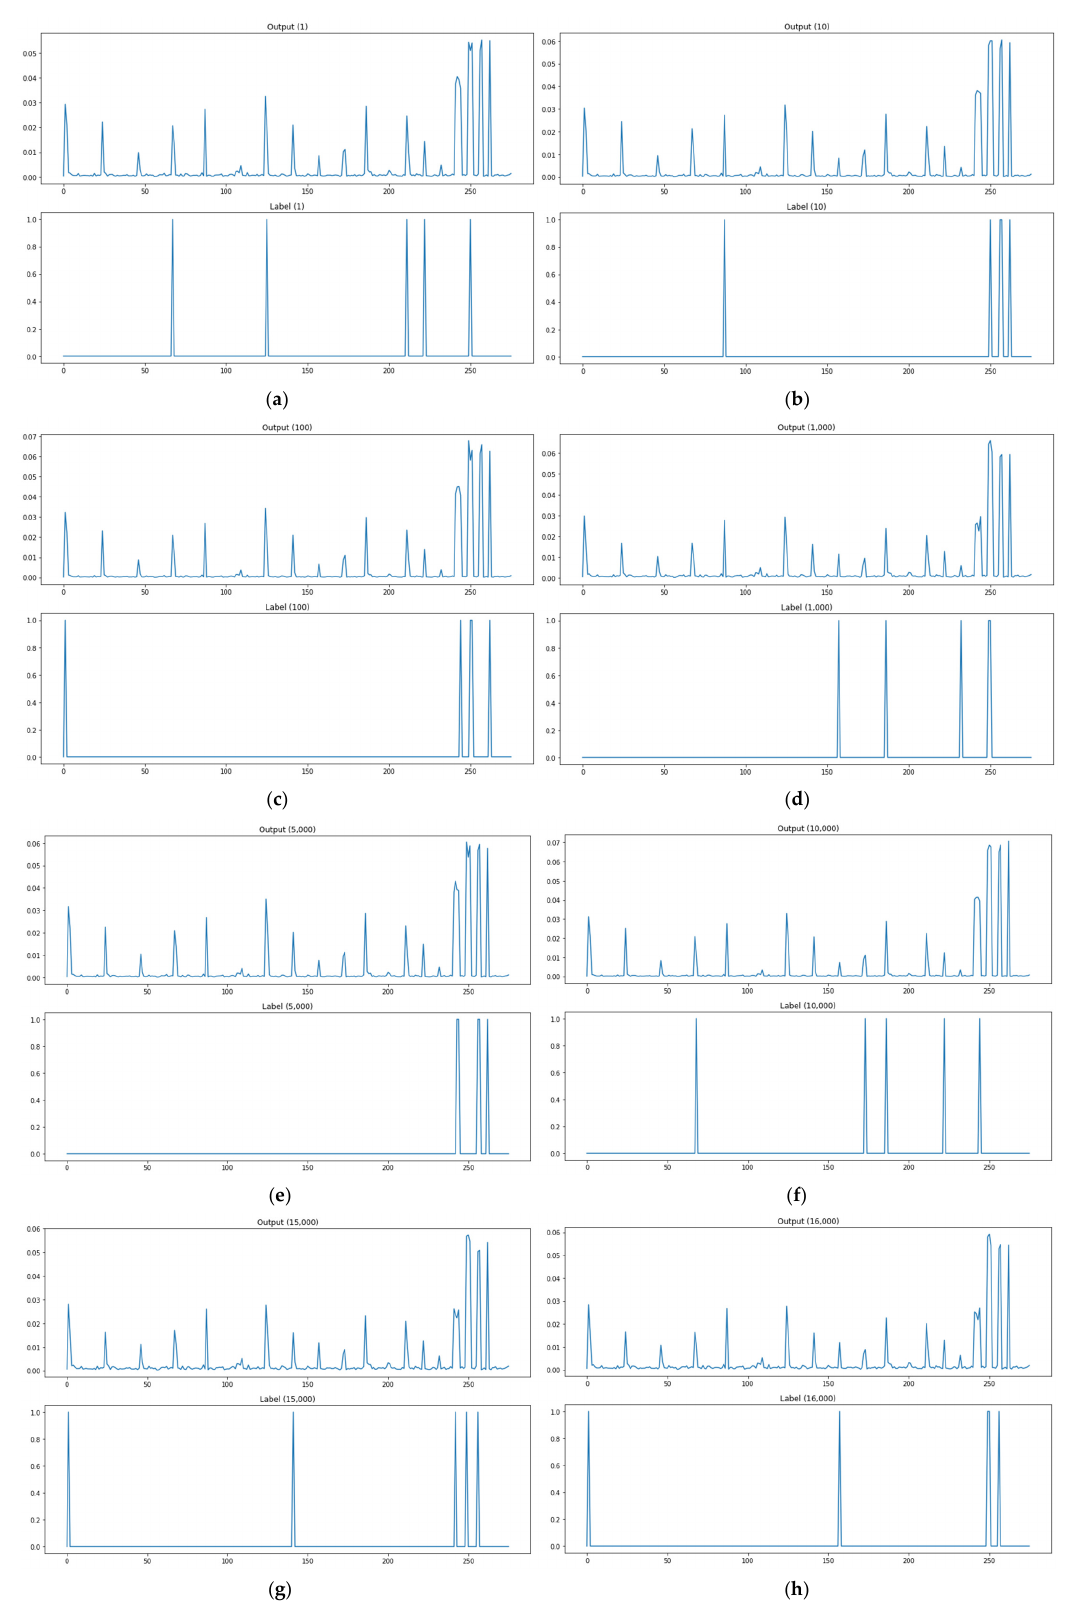
Figure 12. The outputs of the ANN and deep learning—output layer with sigmoid (model 1). ( a ) Test data 1. ( b ) Test data 10. ( c ) Path test data 100. ( d ) Path test data 1000. ( e ) Path test data 5000.